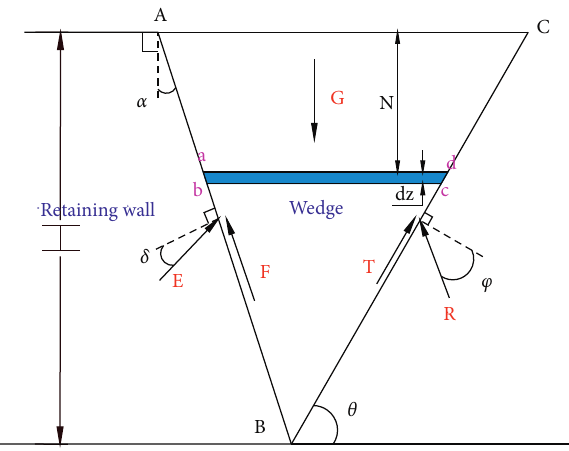
Figure 1: Calculation model of active earth pressure.